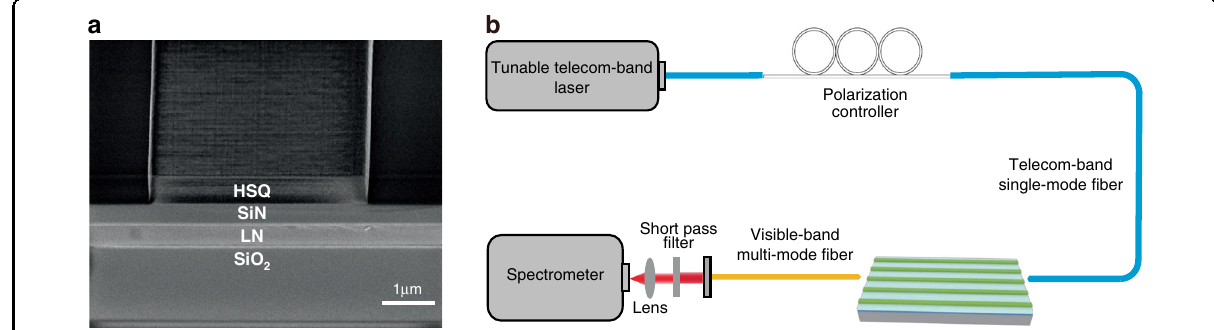
Fig. 3 Device fabrication and characterization. a SEM image of the cross section of the semi-nonlinear waveguide, showing the LN/SiN layers together with the electron-beam resist waveguide. b Experimental setup for the characterization of SHG, which includes an automatic fi ber-to- waveguide coupling system, a tunable telecom-band laser and a